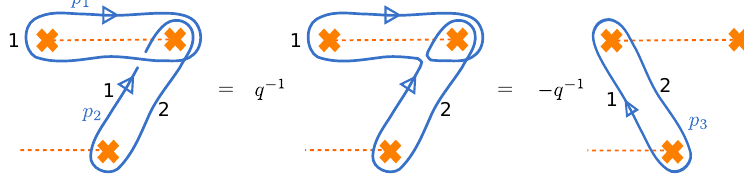
Figure 9 . A sample quantum torus relation. We show a patch of e C , presented as a branched double cover of a patch of C . The covering is branched at the orange crosses, and branch cuts are shown as dashed orange segments. Labels 1 and 2 next to loop segments indicate which sheet of e C they lie on. At a crossing between segments on the same sheet, the x 3 -direction is represented as the \height" (loops which are closer to the eye are ones with a larger x 3 coordinate.) At a \non-local crossing" where two segments on di(cid:11)erent sheets of e C ! C cross, we do not indicate the relative